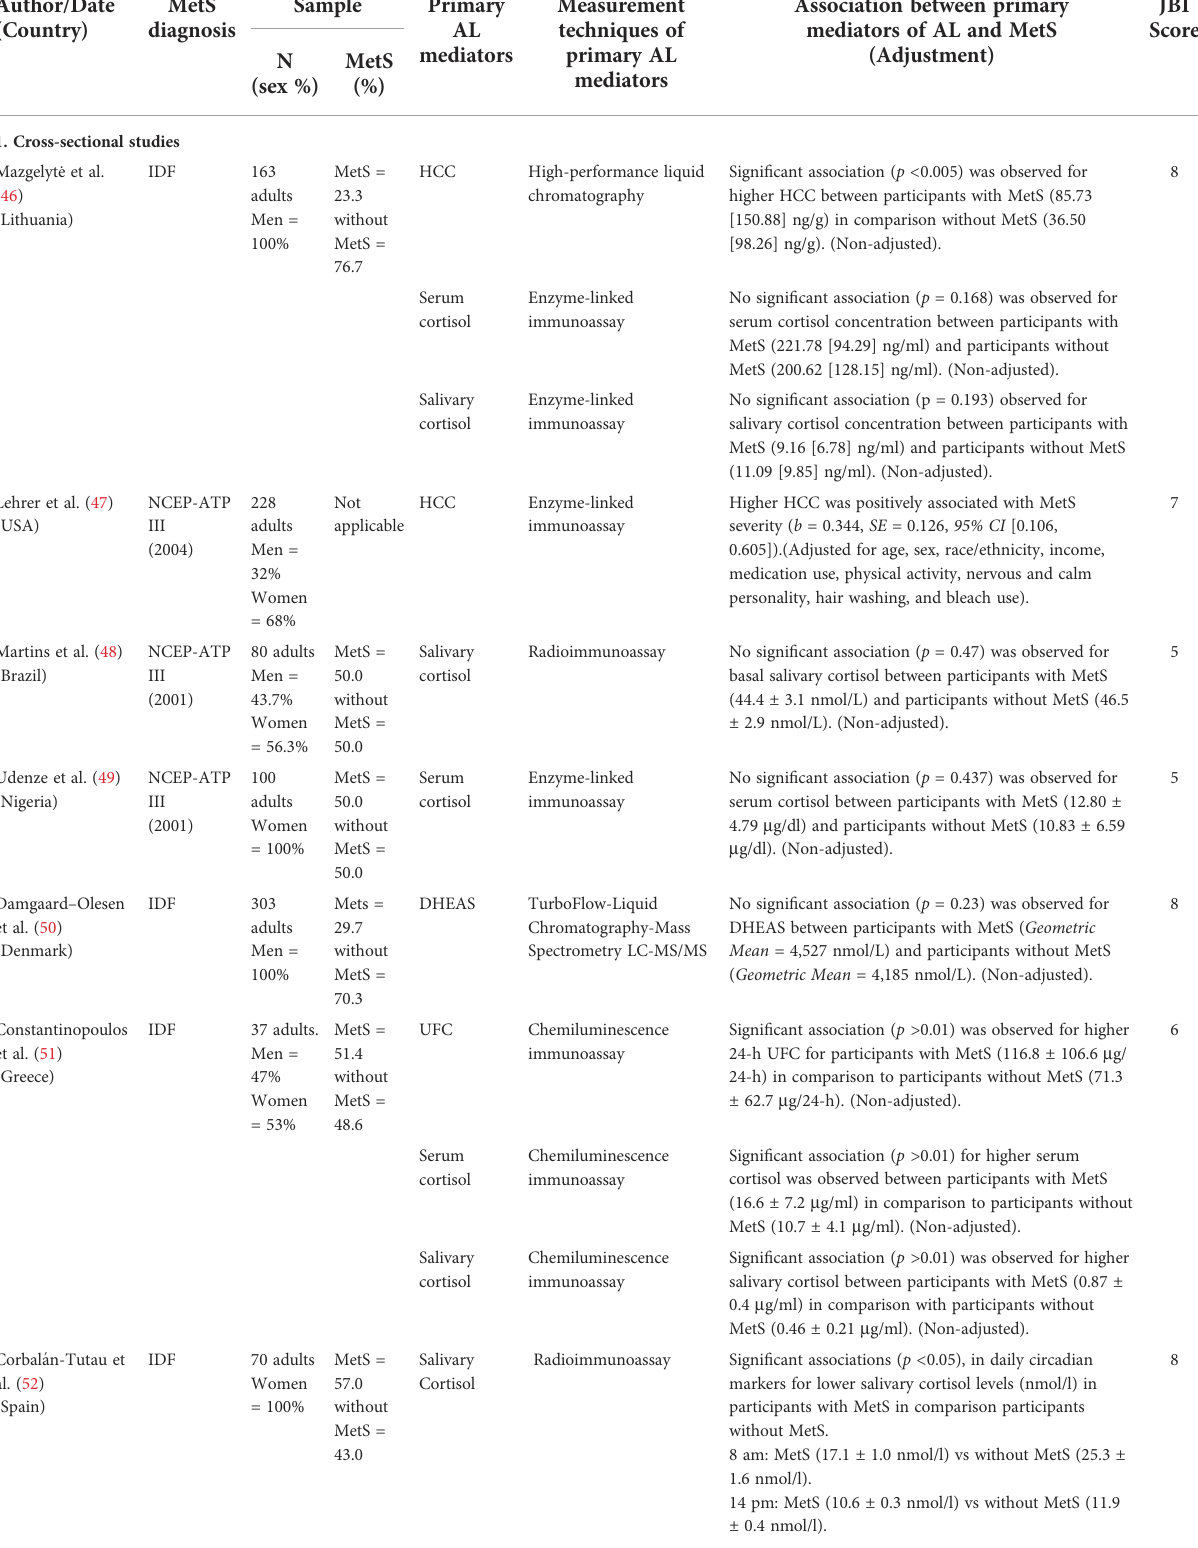
TABLE 1 Study characteristics of the association between the primary mediators of AL and MetS ( n =